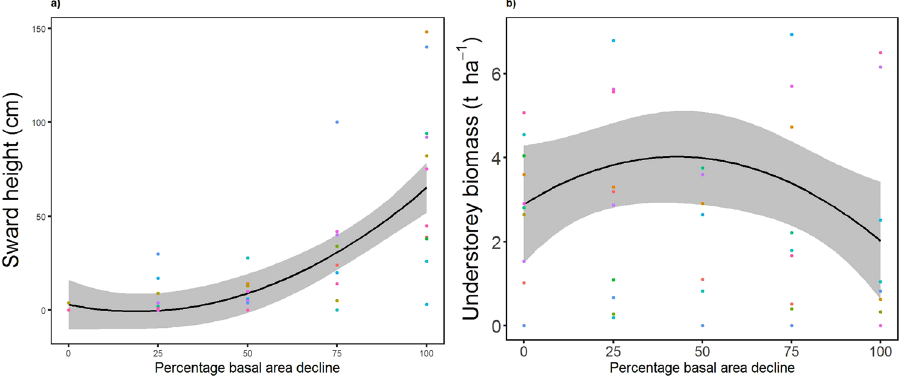
Figure 3. Threshold relationships between stage of dieback and ecosystem condition. Relationships between stage of dieback and ( a ) average sward height (n = 60); and ( b ) understorey biomass (n = 60). The black lines represent prediction using the most parsimonious model coefficients and grey shading the 95% confidence intervals of the coefficients (marginal r 2 = 0.51 and 0.38 for ( a ) and ( b ), respectively). The different coloured points represent the values at each individual